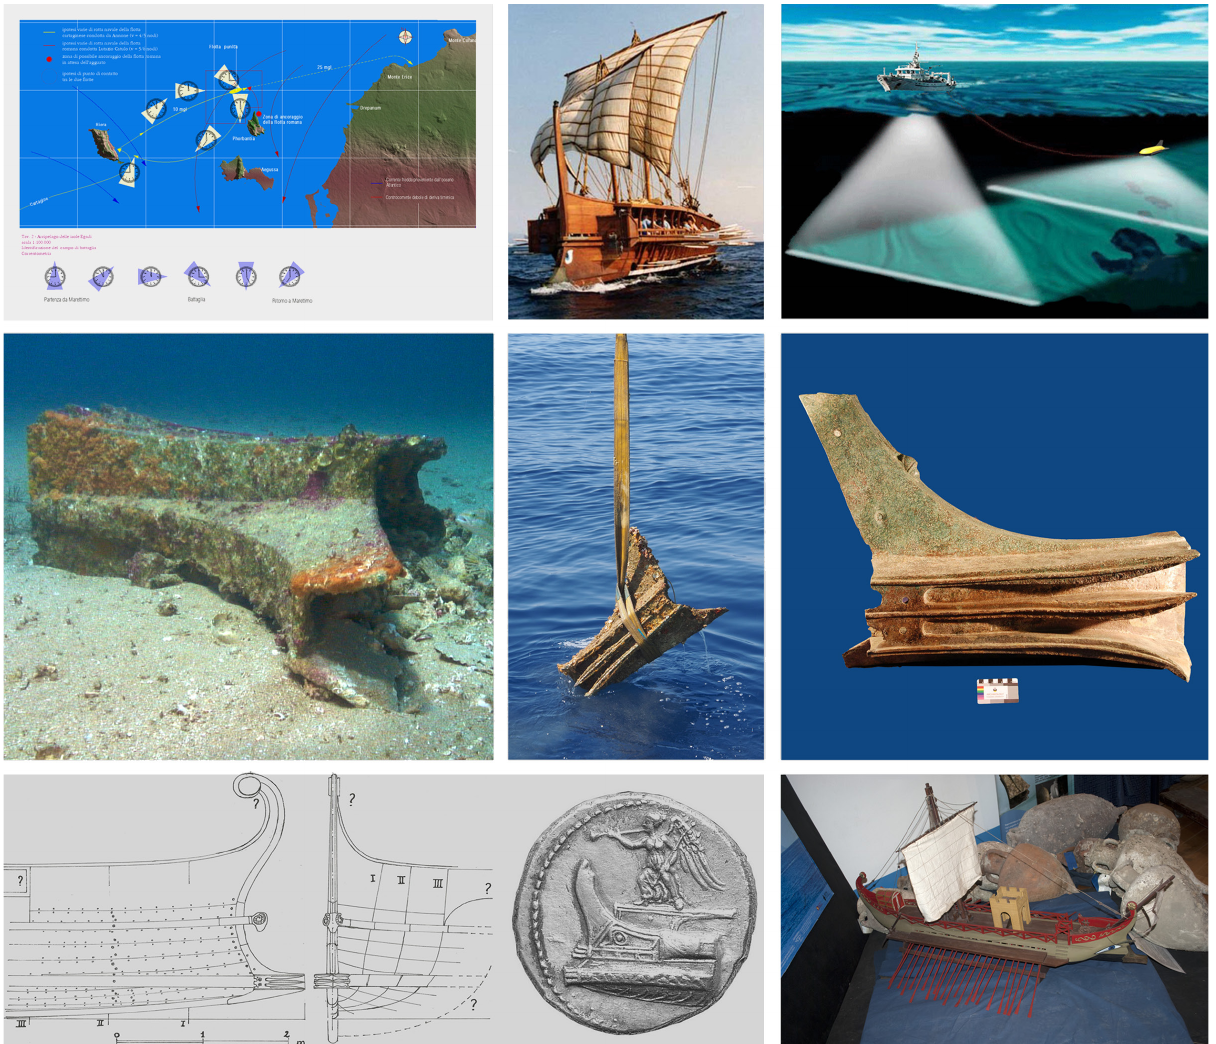
Figure 3. Archaeological research conducted by the Soprintendenza del Mare in the deep waters of the Egadi